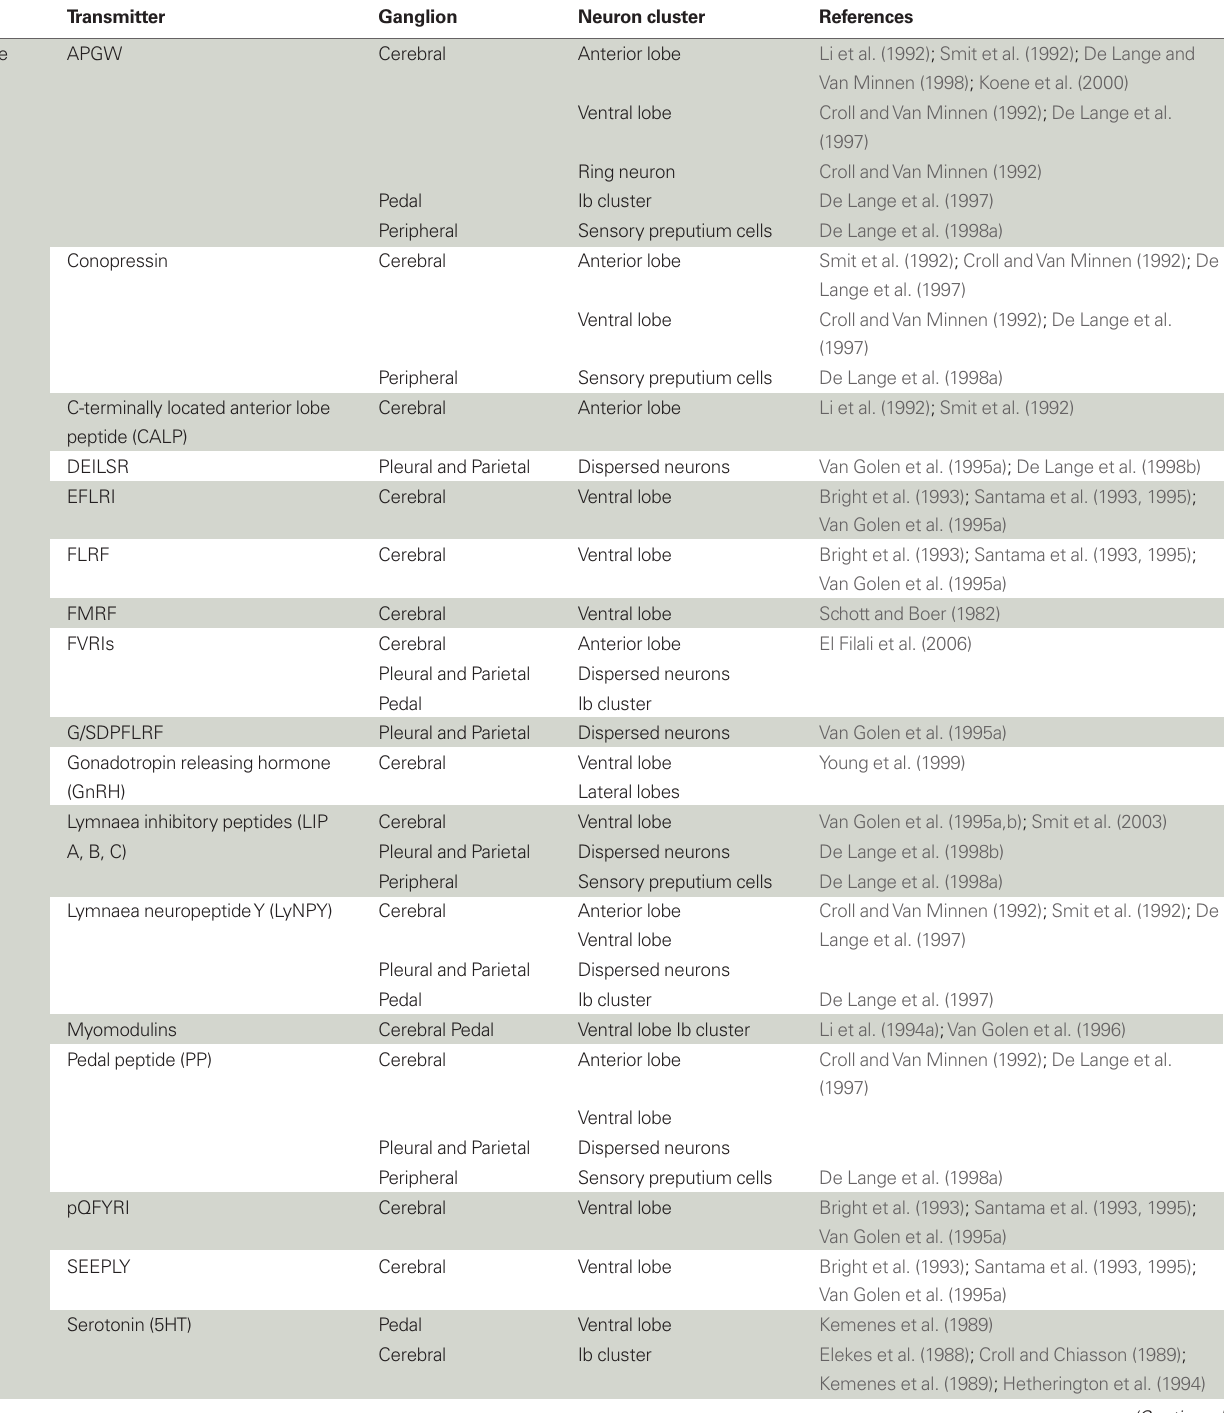
Table 1 | Central and peripheral location of neuro-endocrine substances involved in male and female reproduction of hermaphroditic freshwater